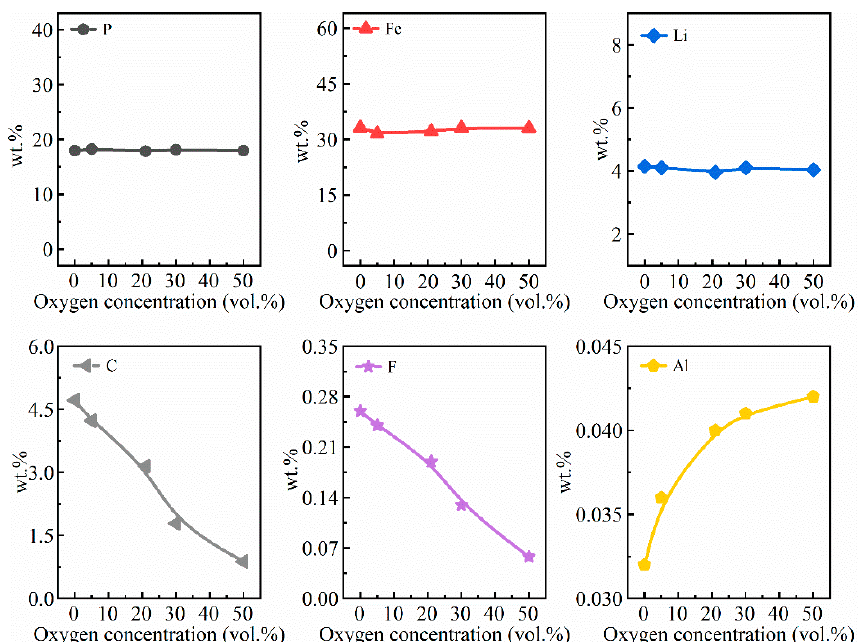
Figure A1. Chemical analysis of calcined cathode materials obtained at different roasting Table 2. Chemical analysis of calcined cathode materials obtained at different oxygen concentrations. Figure A2. Chemical analysis of calcined cathode materials obtained at di ff erent oxygen concentrations.